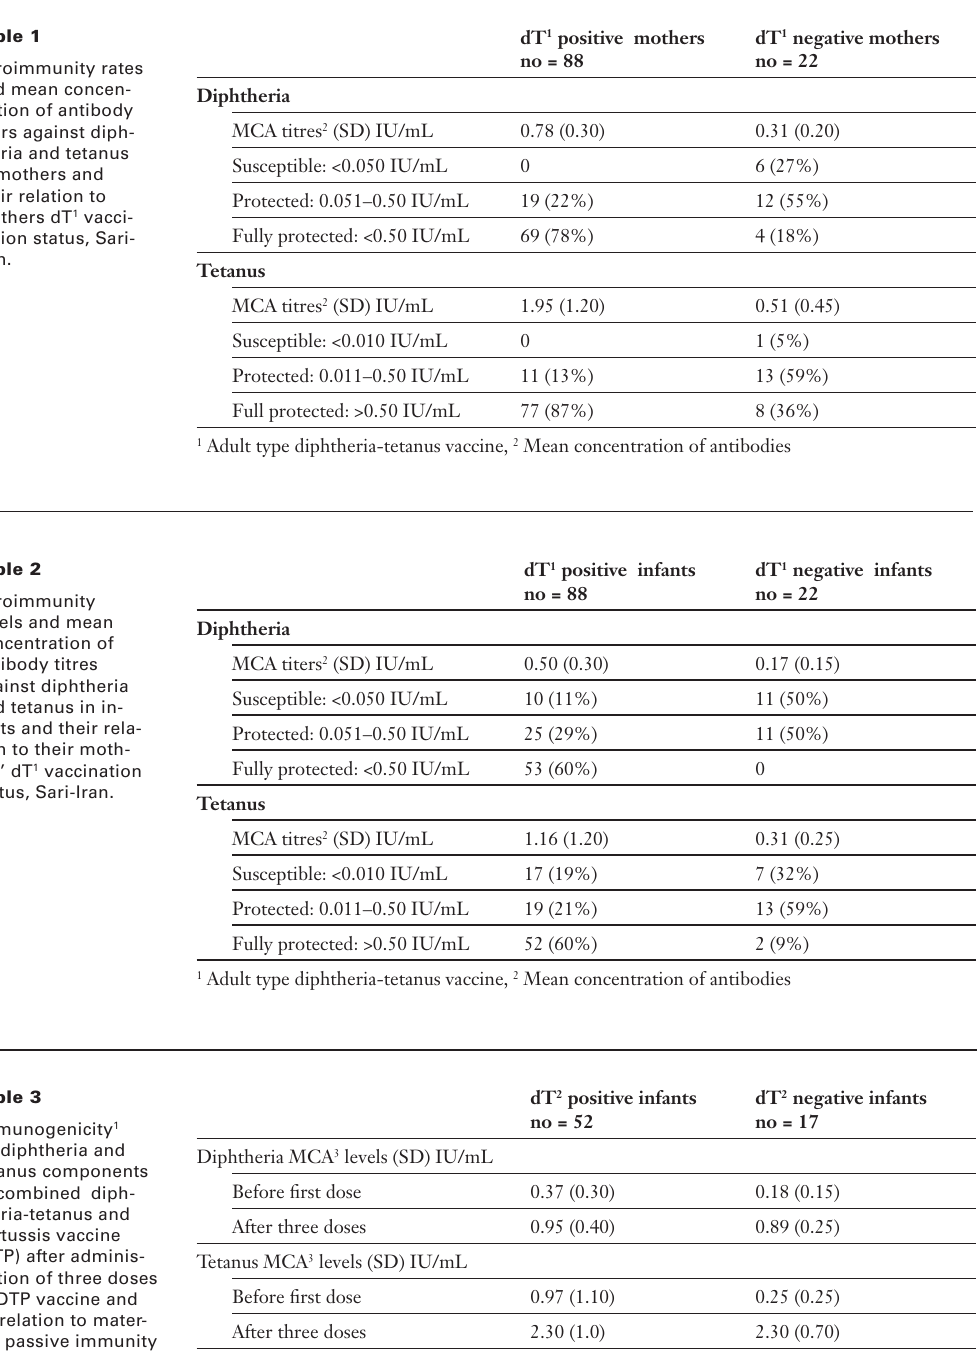
Table 1 Seroimmunity rates and mean concen- tration of antibody titers against diph- theria and tetanus in mothers and their relation to mothers dT 1 vacci- nation status, Sari- Iran.